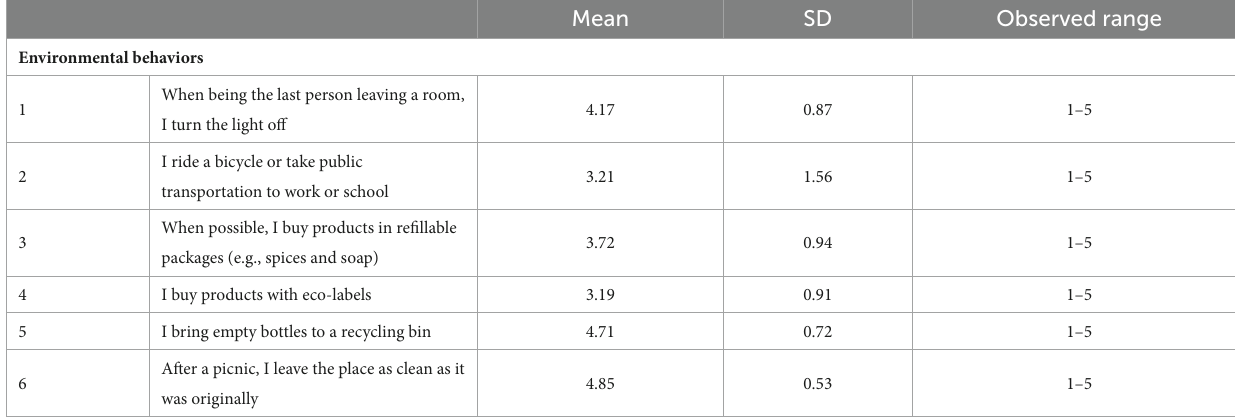
TABLE 2 Summary statistics of the environmental behaviors.